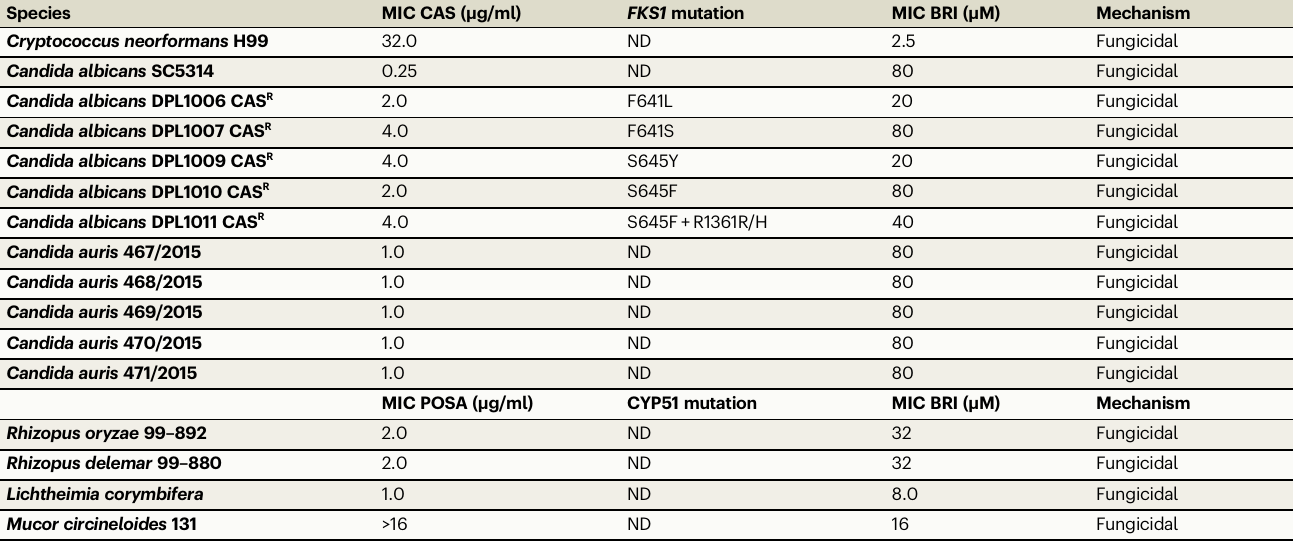
Table 2 | Brilacidin MICs for human pathogenic